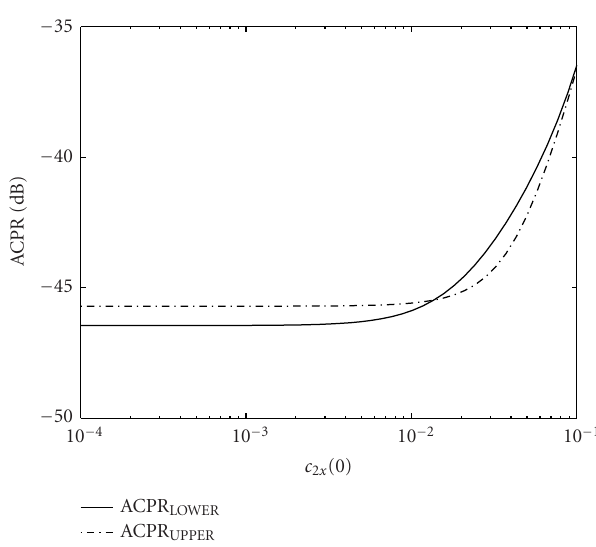
Figure 5: ACPR LOWER (solid line) and ACPR UPPER (dashed-dotted line) as a function of the input power c 2 x (0) for a PA with